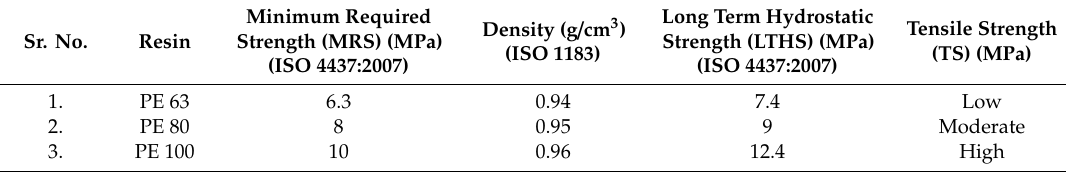
Table 1. Detailed specifications of polyethylene (PE) variants.